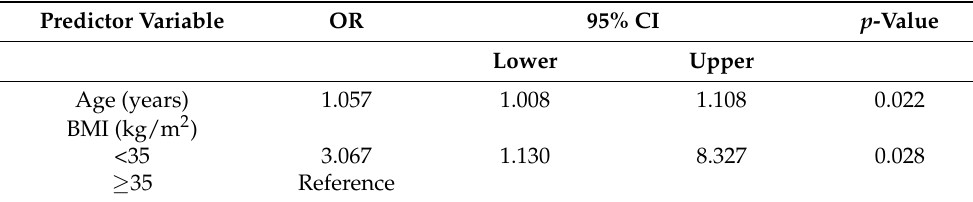
Table 3. Results of multivariable analysis with logistic